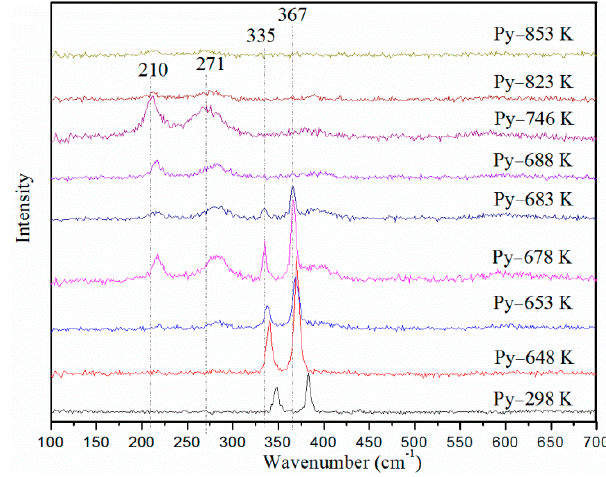
Figure 2. Raman shift of pyrite during heating (298–853 K).